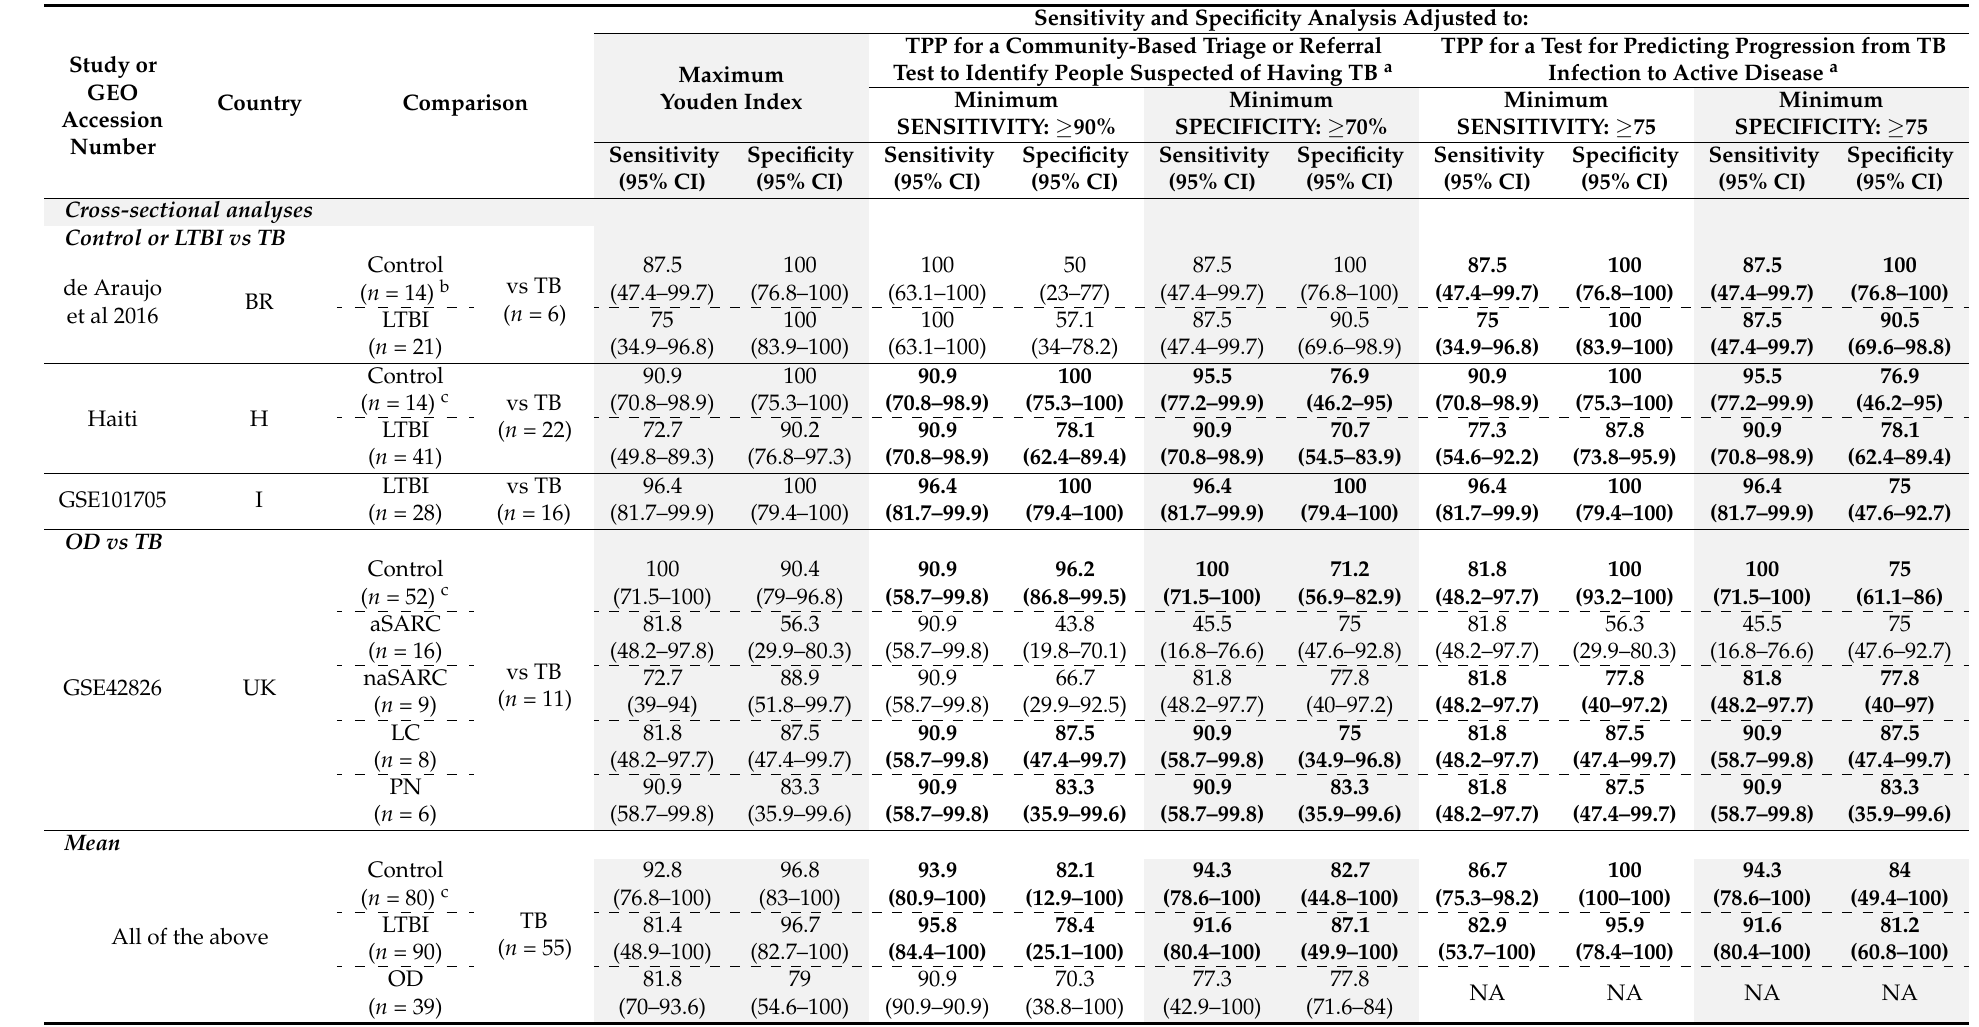
Table 3. Accuracy of NPC2 transcription s following WHO ´ s target product profile (TPP) for blood biomarkers for